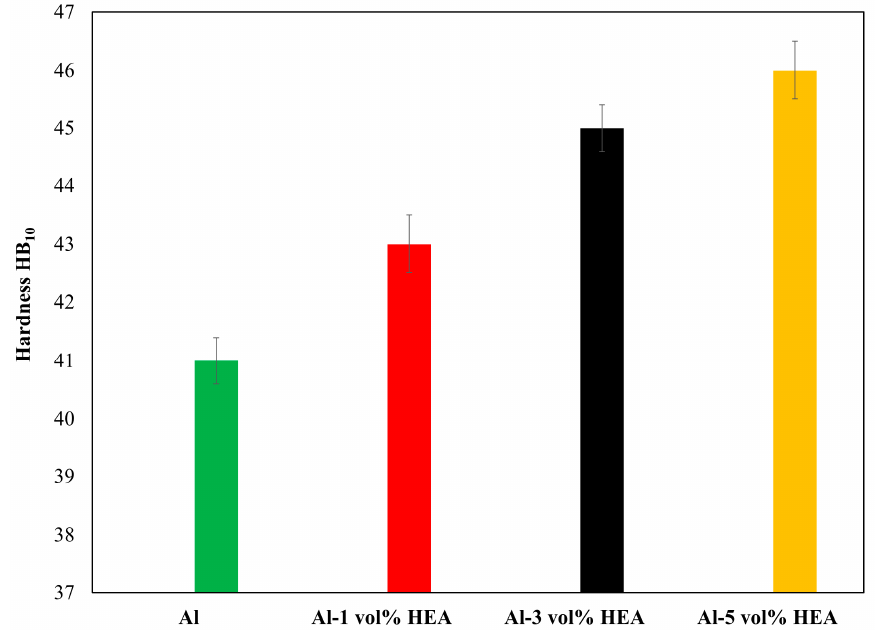
Figure 5. Hardness values for monolithic Al and Al ‐ HEA composites.